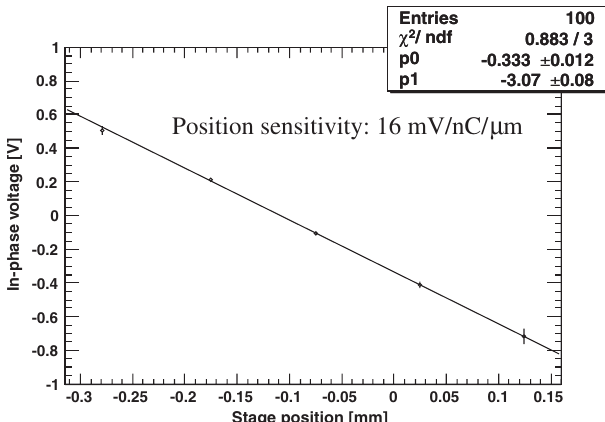
FIG. 3. Position detection sensitivity of the cavity-type BPM. The sensitivity is 16 mV = nC =(cid:1) m .